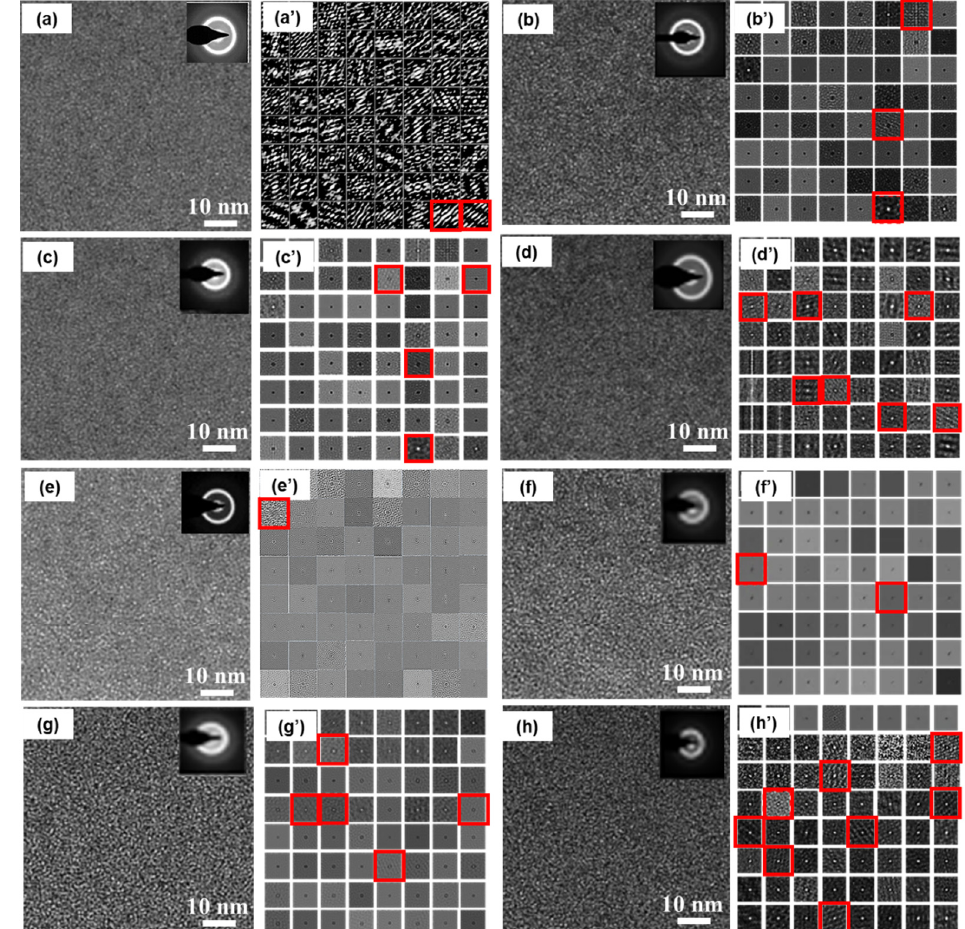
Figure 5. HRTEM images with inset showing the selected area electron diffraction patterns of Ni- and Fe-based samples. ( a ) melt-extracted Ni-based sample, and Ni-based samples annealed at ( b ) 600 °C for 10 min, ( c ) 600 °C for 20 min, ( d ) 650 °C for 10 min; ( e ) melt-extracted Fe-based sample, and Fe-based samples annealed at ( f ) 550 °C for 10 min, ( g ) 550 °C for 20 min, ( h ) 580 °C for 20 min, and the corresponding ACF images ( a ′ – h ′ ).